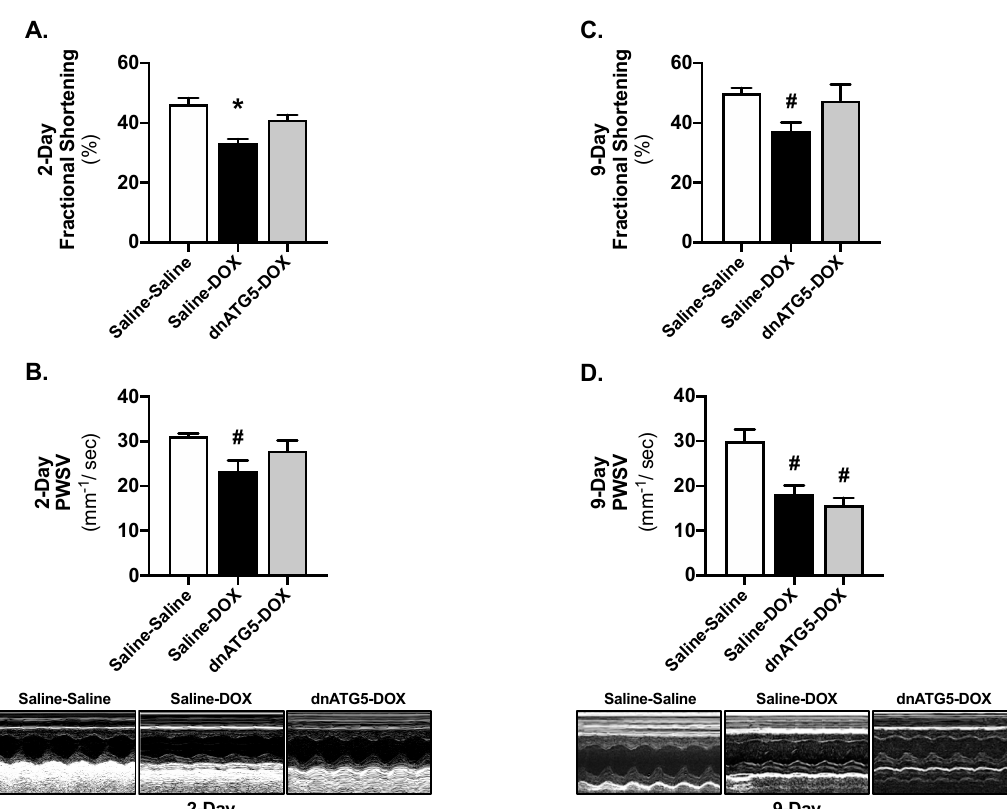
Figure 2. Fractional shortening and posterior wall shortening velocity. Fractional shortening percentage (%) measured at the ( A ) 2-day and ( C ) 9-day timepoints. Posterior wall shortening velocity (PWSV) analyzed at the ( B ) 2-day and ( D ) 9-day timepoints. Representative M-mode images are displayed below the graphs for the 2-day and 9-day timepoints. Values are presented as means ± SEM, n = 6–9/group. * significantly different versus all groups ( p < 0.05). # significantly different versus Saline-Saline ( p < 0.05).